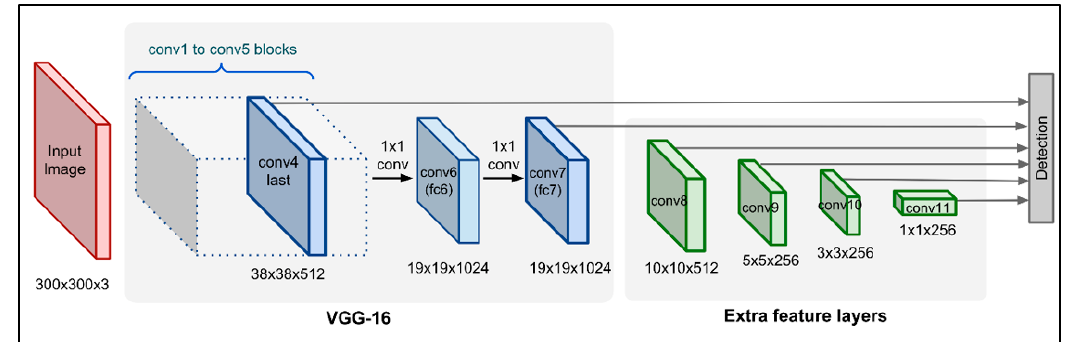
Figure 1. Block diagram of the Single Shot Multibox Detector (SSD).